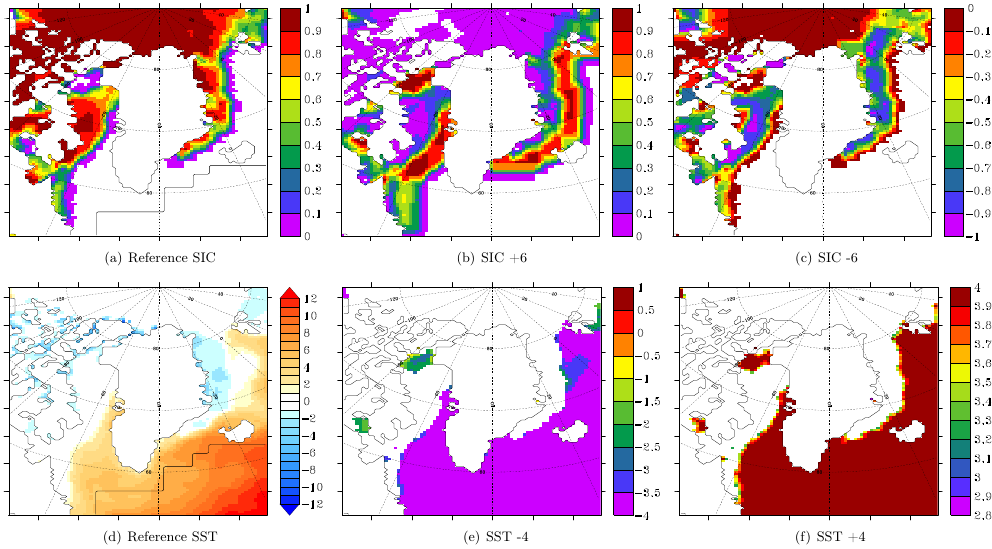
Figure 1. Panel representing the entire integration domain used for every simulations. Top: reference simulation (a) SIC (% normalized to 1) and anomalies in SIC from the sensitivity experiment (b) SIC + 6, (c) SIC − 6 on the 1 June 2012. Bottom: reference simulation (d) SST ( ◦ C) and anomalies in SST from the sensitivity experiment (e) SST − 4, (f) SST + 4 on the 1 June 2012. The black box area depicted in (a) and (d) is used to calculate SST in Table 1.